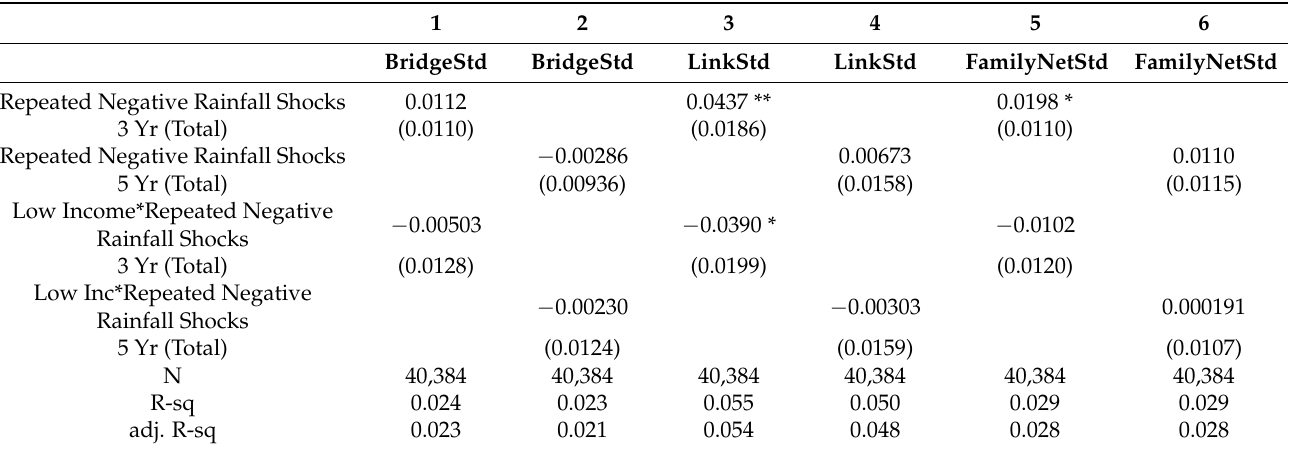
Table A4. Results assessing the impacts of repeated negative rainfall shocks on key measures of social capital (low-income villages).